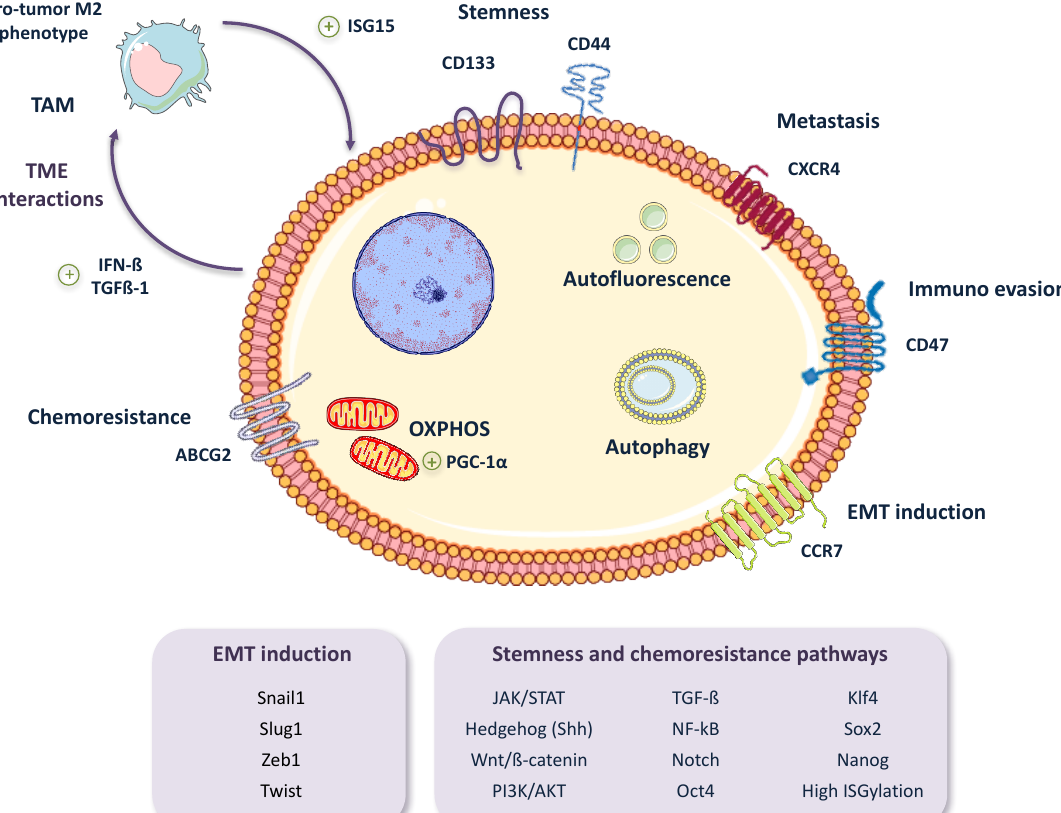
Figure 3. Pancreatic CSCs features. Pancreatic CSCs (PaCSCs) include various CSC subpopulations with distinct characteristics. This figure shows some of the PaCSCs features, which may not be shared between all subpopulations. PaCSCs can express several markers for stemness, metastatic potential, immuno evasion and chemoresistance, as well as receptors for epithelial to mesenchymal transition (EMT) induction. Oxidative phosphorylation (OXPHOS) is a key feature of PaCSCs, as is enhanced autophagy and the accumulation of autofluorescent vesicles. Numerous stemness and chemoresistance signaling pathways may also be activated, strengthening CSC survival and PDAC progression, as well as relapse after treatment. JAK/STAT (Janus tyrosine Kinase/Signal Transducer and Activator of Transcription); PI3K (phosphatidylinositol 3-kinase); PGC-1 α (Peroxisome proliferator-activated receptor γ co-activator 1 α